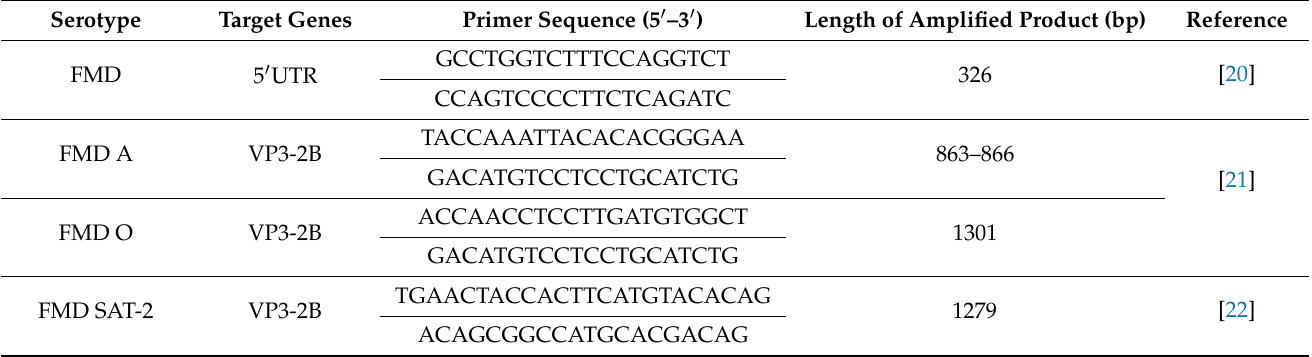
Table 1. Primer sequences, target genes, and amplicon sizes, used for characterizing foot and mouth disease virus (FMDV). Serotype Target